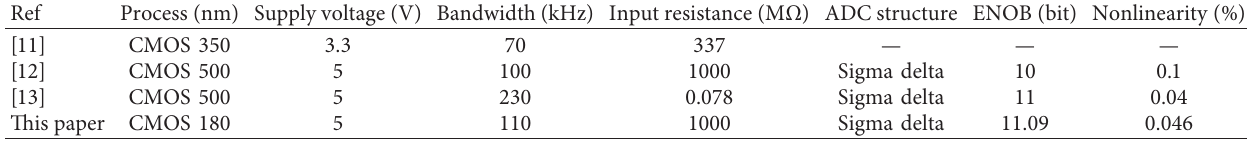
Figure 11: ENOB vs. temperature. Table 1: Performance